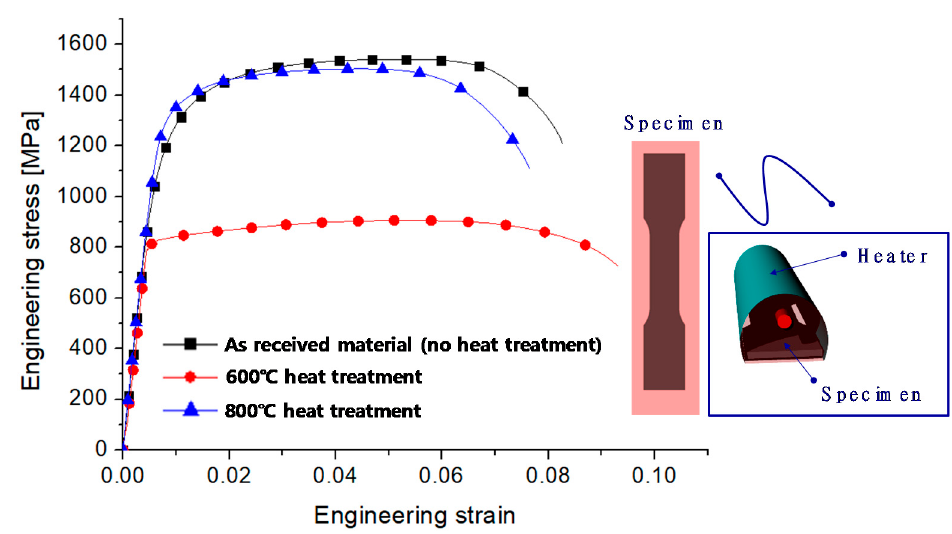
Figure 7. Tensile test after the IR heat treatment.